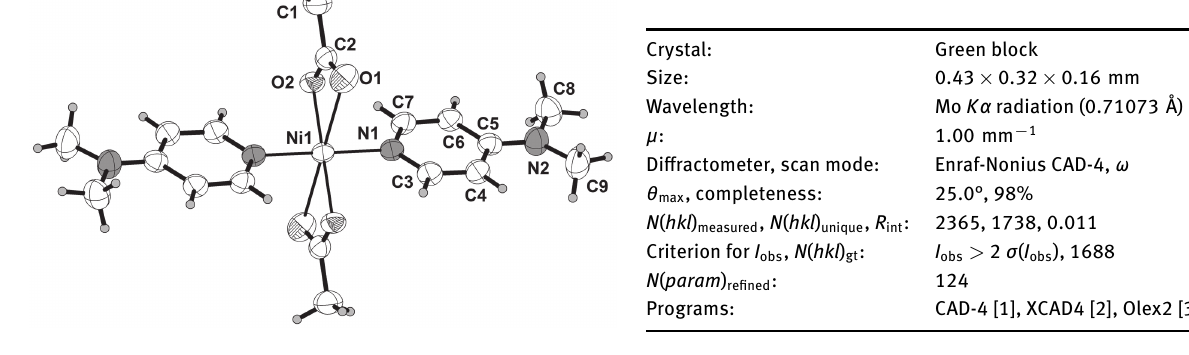
Table 1: Data collection and handling.